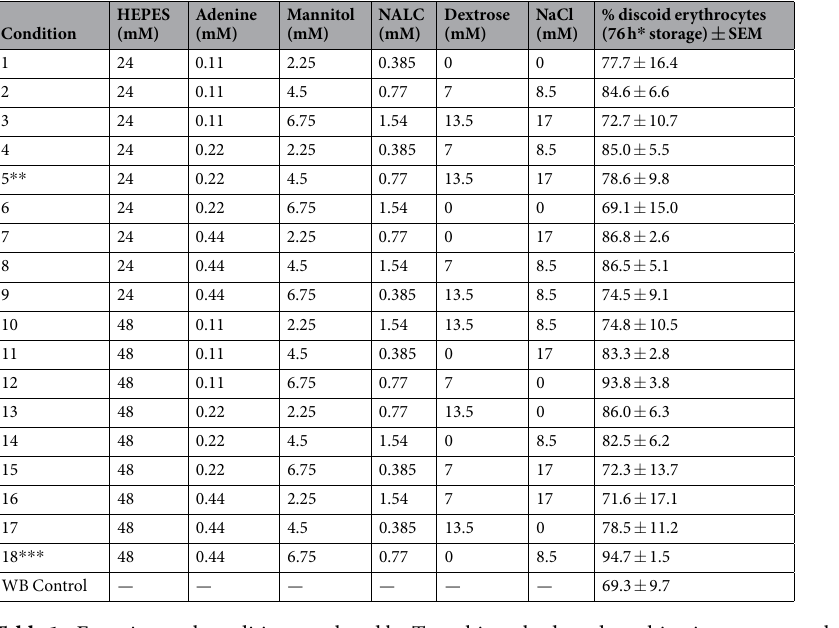
Table 1. Experimental conditions explored by Taguchi methods and resulting impact on erythrocytes. * following 72 h ambient storage, cells were incubated 4 h with adenosine (76 h total). ** CS-Original formulation. *** CS RBC